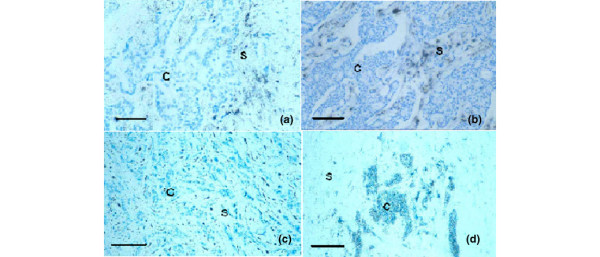
Expression of matrix metalloproteinase (MMP)-2, MMP-14 and tissue inhibitor of metalloproteases (TIMP)-2 in stromal and cancer cells. (a) MMP-2 expression by stromal cells (in situ hybridization, × 200); (b) MMP-14 expression by stromal cells (in situ hybridization, × 200); (c) TIMP-2 expression by stromal cells (in situ hybridization, × 200); (d) TIMP-2 expression by cancer cells (in situ hybridization, × 200). Scale bar = 200 microns. C, cancer cells; S, stromal cells.